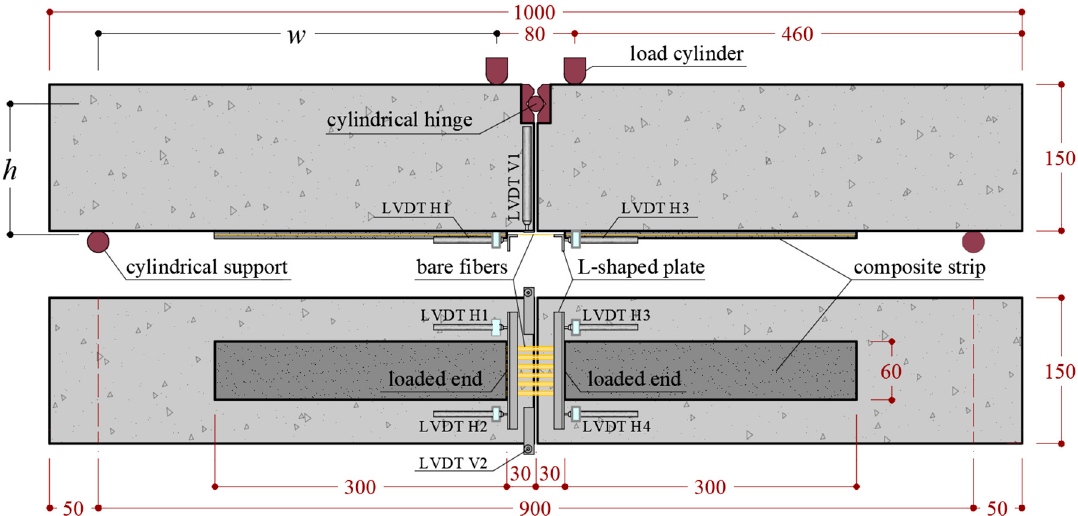
Figure 3. Modified beam test geometry (dimensions in mm).